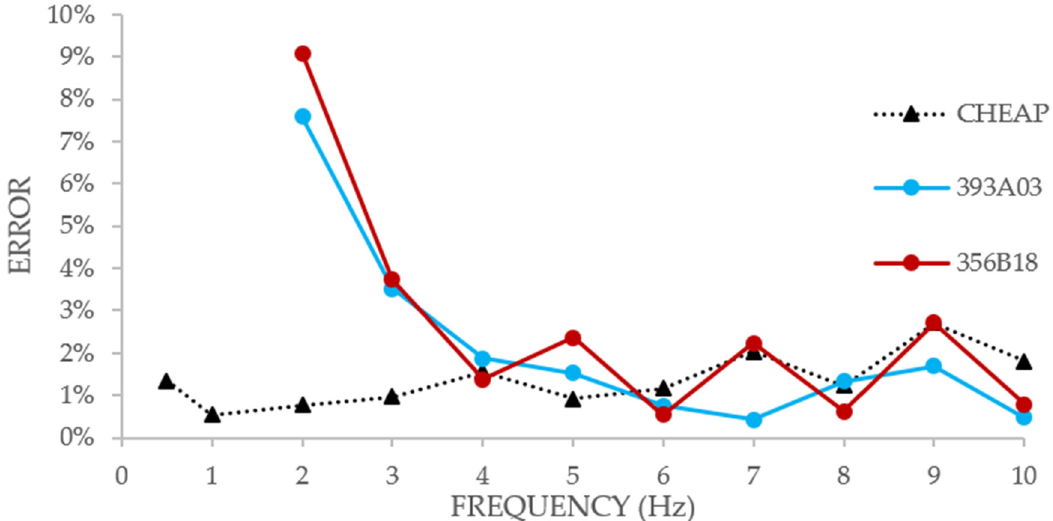
Figure 4. Comparing MA error of the two control systems with CHEAP.